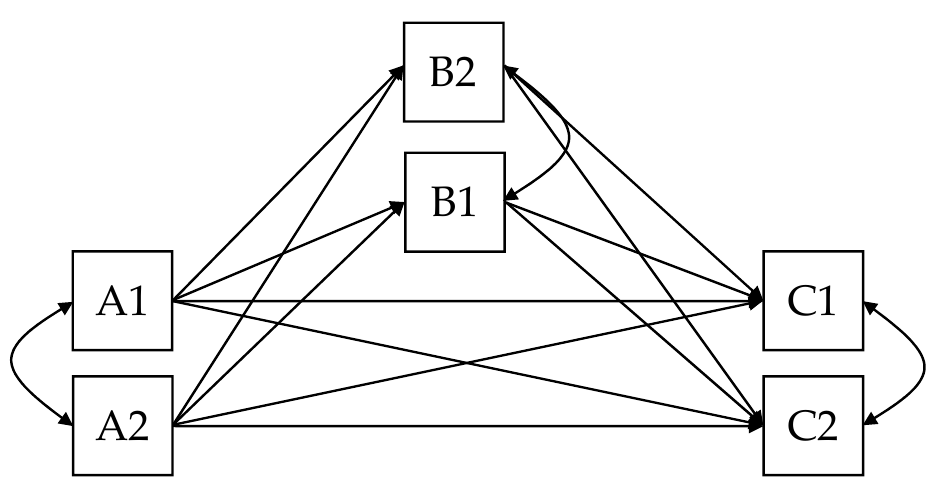
Figure 1. Simplified Partial Mediation Model. This figure depicts a partial mediation model where A and C are directly related, but the effect is also partially mediated by B.